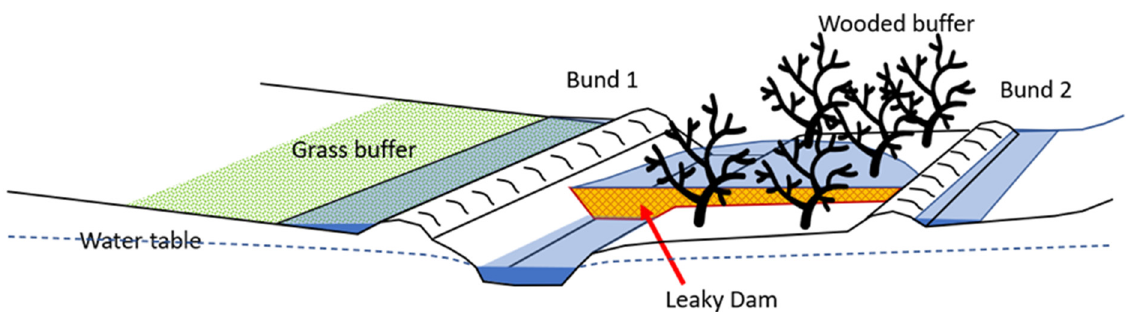
Figure 6. A classification of RAF features. The width of the effective inundation zone increases with scale and Strahler order. Label A is a highly modified widened farm ditch with sediment traps.